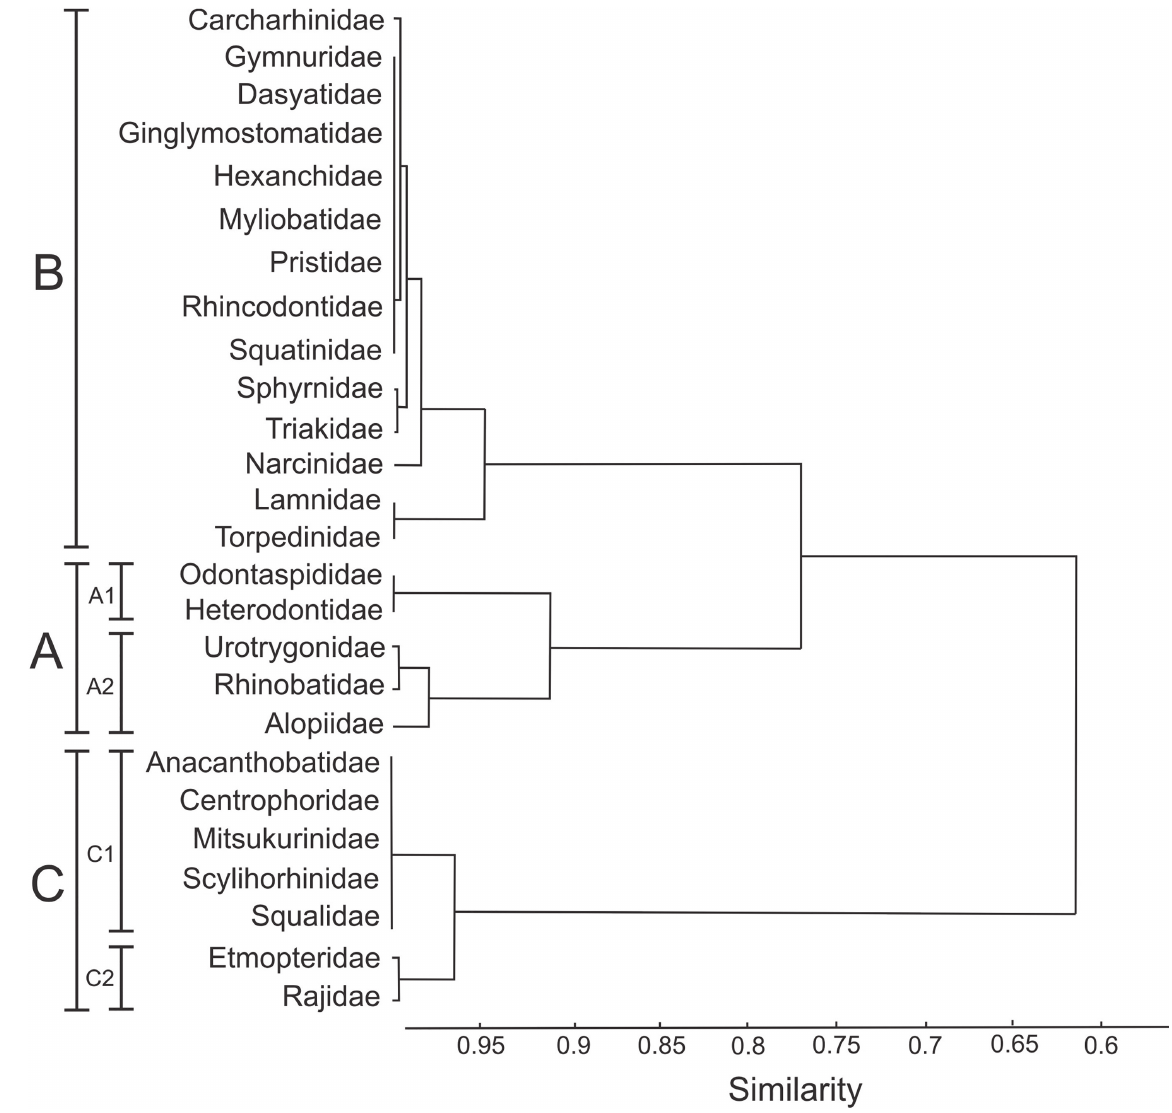
Fig. 3 . Similarity analysis of elasmobranch families per number of species present in the Colombian Caribbean and Pacific. A: Pacific-associated; B: Associated with both areas, Caribbean and Pacific; C: Caribbean-Associated. The subgroups in A (A1, A2) and C (C1, C2) correspond to families exclusive to the area or shared but predominant in the area,